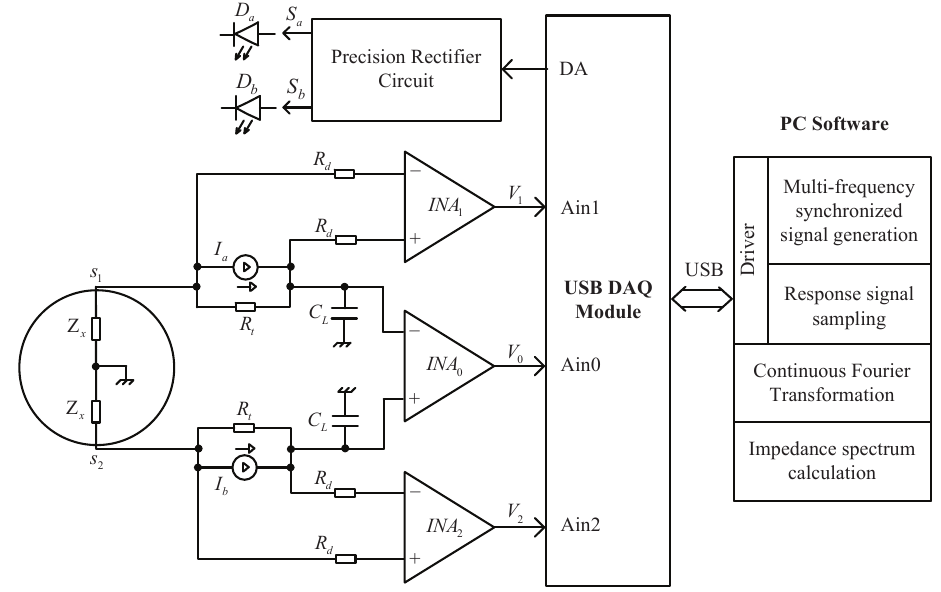
Figure 5. Waveform of the dual-base power sequence (DBPS) signal F(2, 3, ω 0 , t) in one